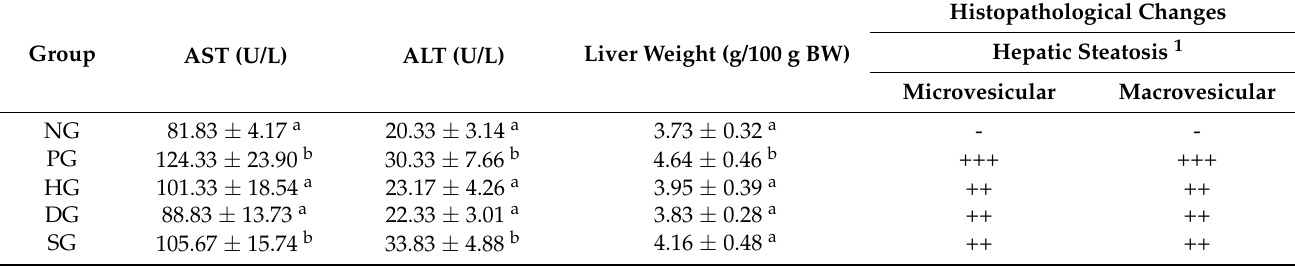
Table 3. Histopathological changes and liver weight in rats treated with DPO and DDP. Group Liver Weight (g/100 g BW)